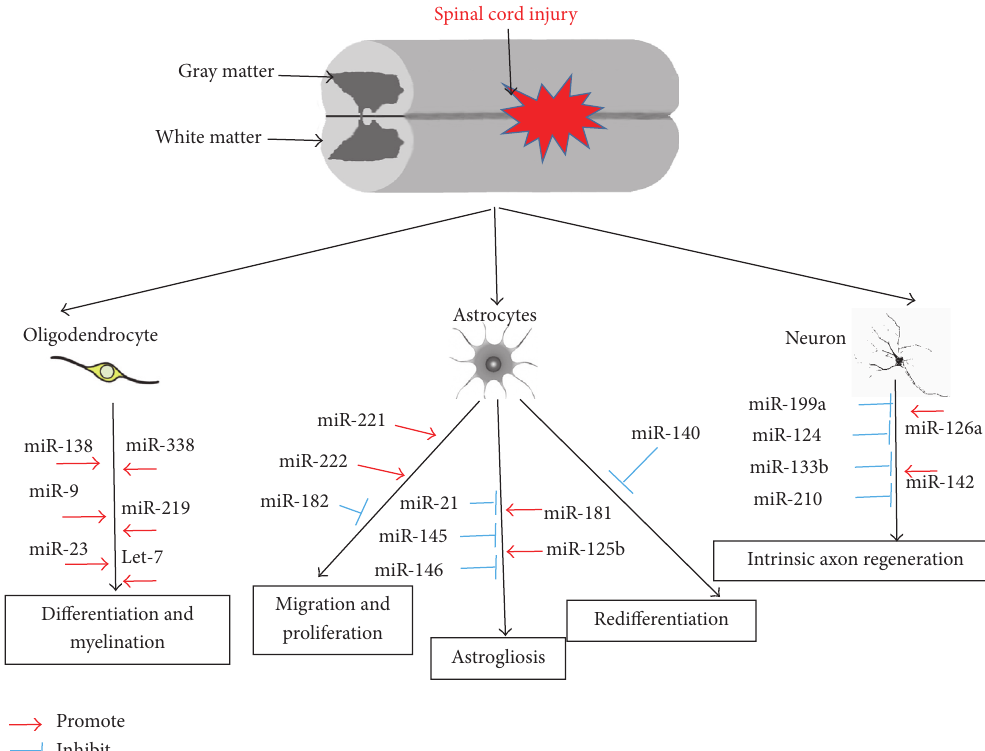
Figure 1: MicroRNAs in the pathogenesis of SCI. SCI triggers a series of pathophysiological responses in the spinal cord, including axon myelination, astrocyte activation, and intrinsic axon regeneration. The activation and inhibition of microRNAs are indicated by a red arrow line and a blue T-shape line,